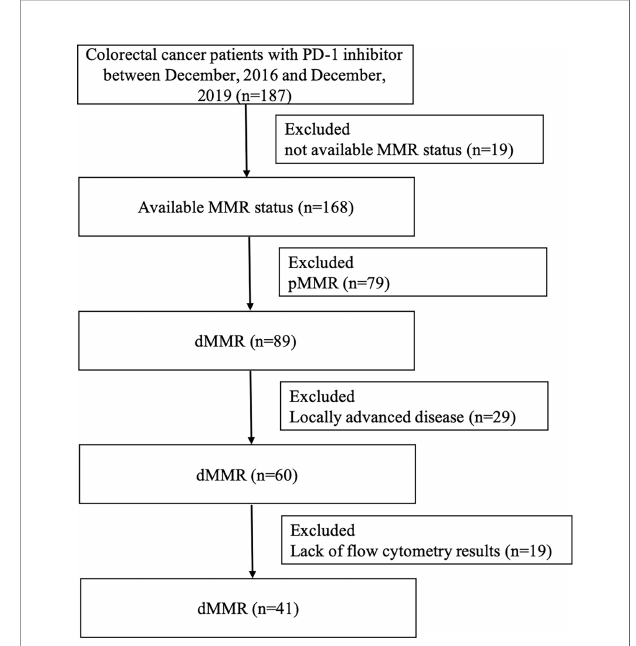
FIGURE 1 | Flowchart depicting patient selection. PD-1, programmed cell death 1; MMR, mismatch repair; dMMR, de fi cient mismatch repair; pMMR, pro fi cient mismatch